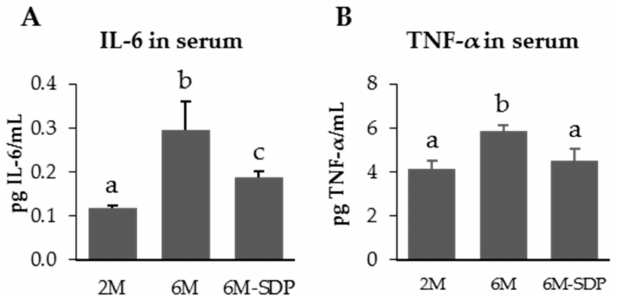
Figure 4. Serum concentration of IL-6 ( A ) and TNF- α ( B ) of SAMP8 mice of the 2-month-old (2M), 6-month-old (6M), and 6-month-old fed spray-dried plasma (6M-SDP) groups. Results are expressed